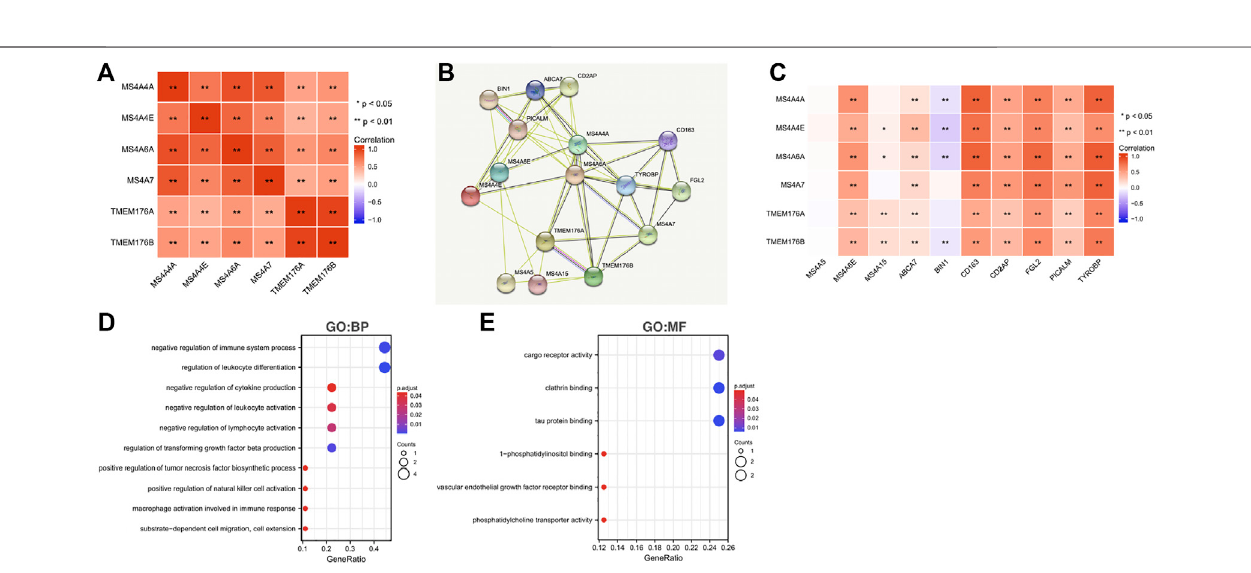
Frontiers in Genetics |